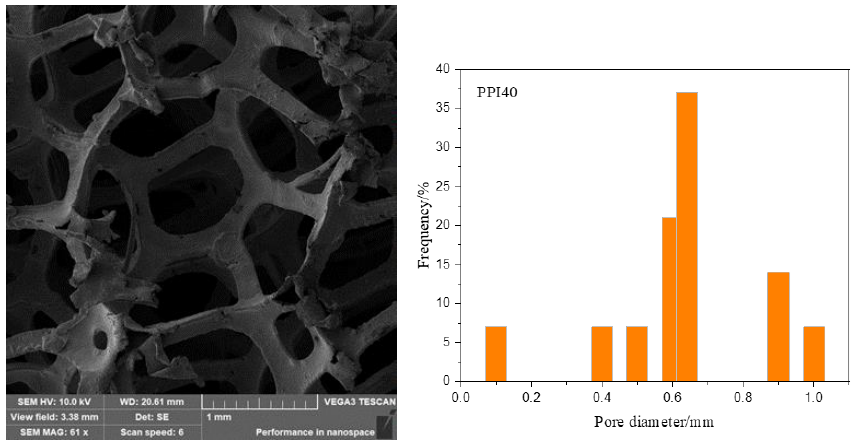
Figure 2. SEM image and pore diameter distribution of PPI40 .